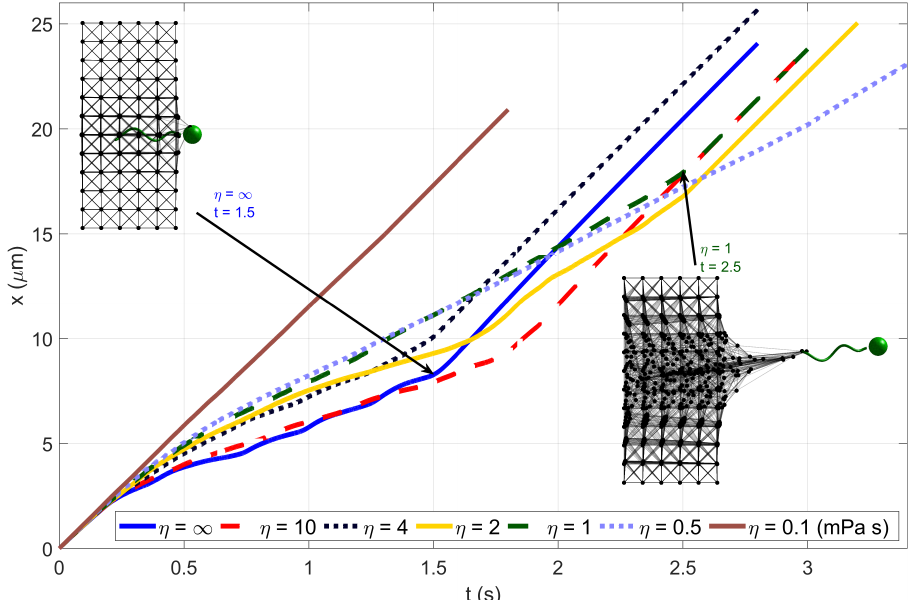
Figure 6. Horizontal position of center of swimmer body as a function of time for a variety of different values of η , the dashpot constant. Note that in each case the link stiffness was E = 25 mPa. The insets show snapshots in time of two particular